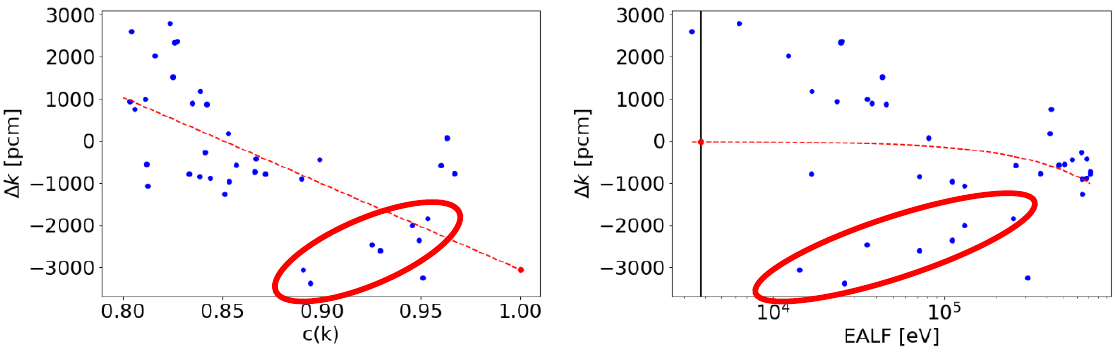
Figure 4b and 4c. The error between the model and the corresponding experiment as a function of c